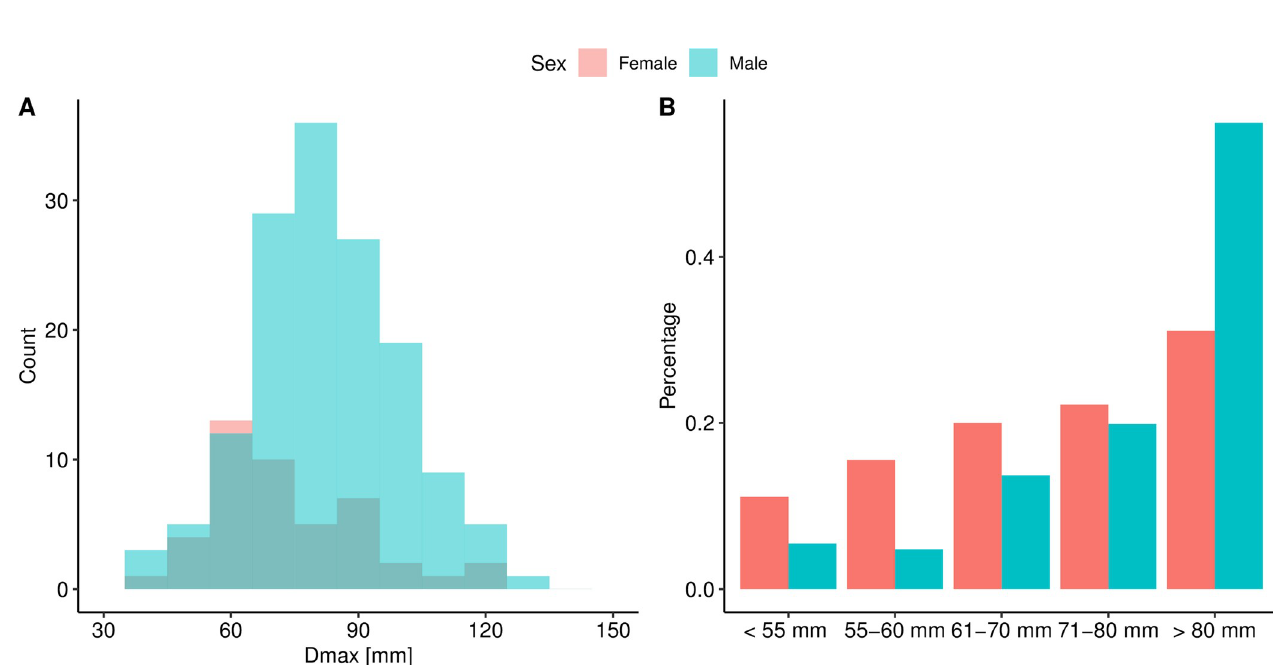
Fig 2. (A) Histograms displaying Dmax at rupture for men and women. (B) Bars indicate the proportions among men and women with ruptured abdominal aortic aneurysms according to Dmax.